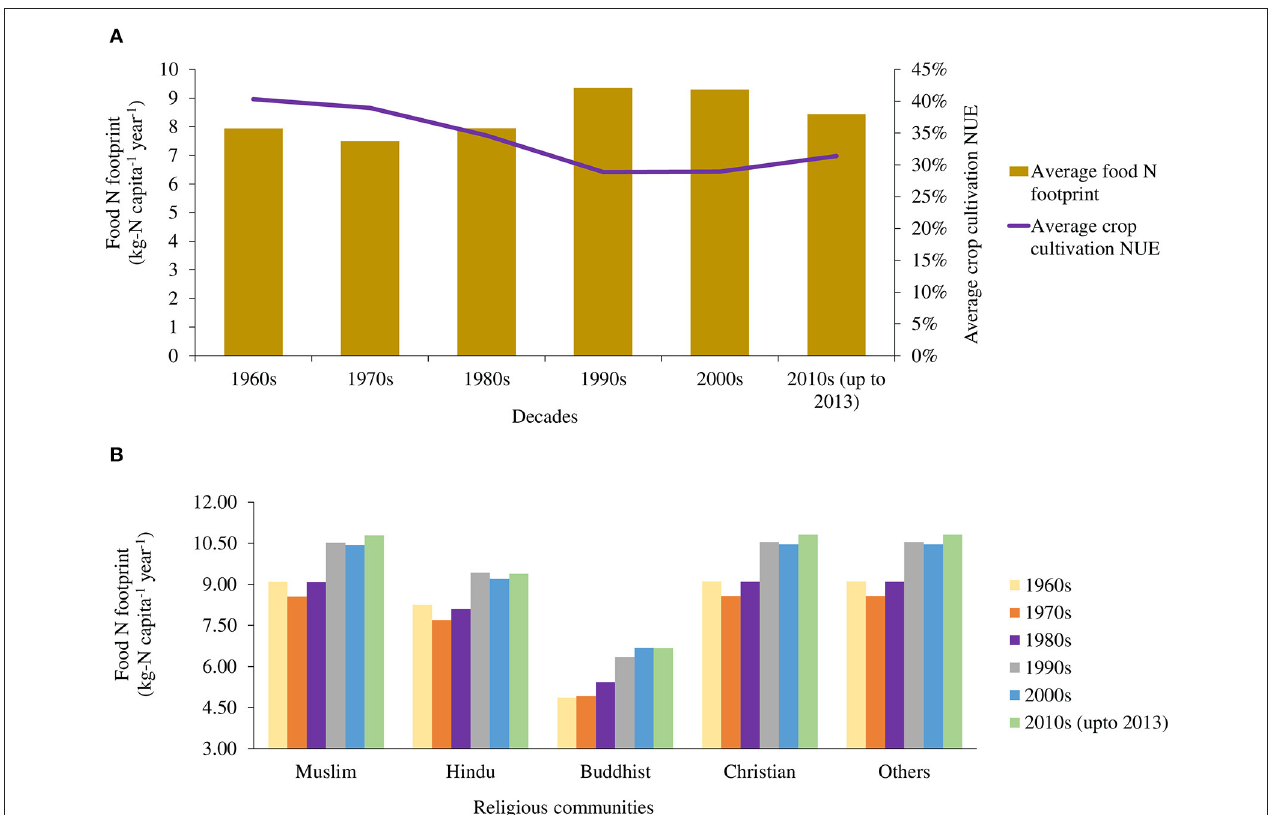
FIGURE 2 | Food N footprint of the ISC (A) regional average with crop cultivation NUE and (B) by religious